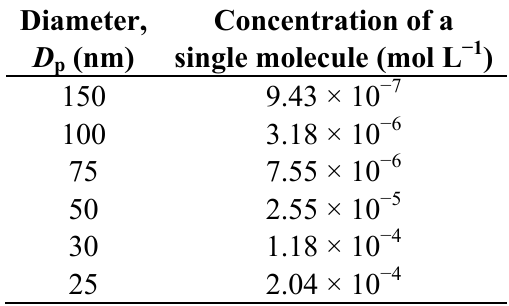
Table 3. Concentration of a single molecule in a